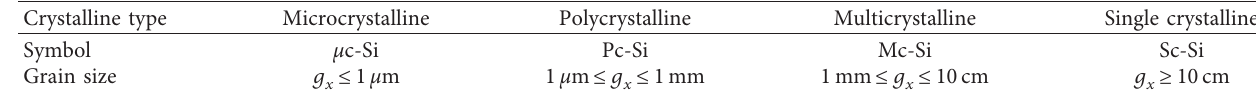
Table 1: Classification of the grain